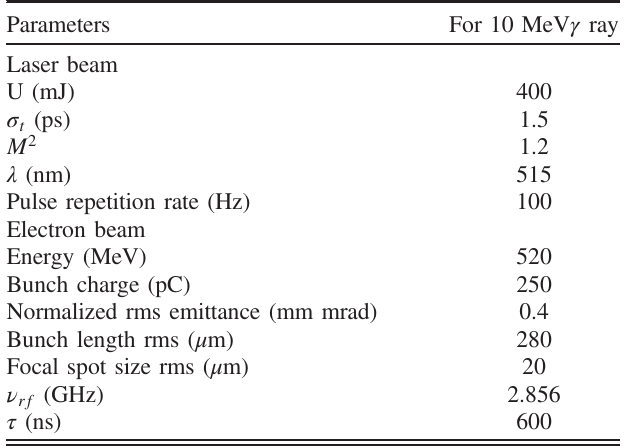
TABLE I. Summary table of the adopted electron beam and laser beam